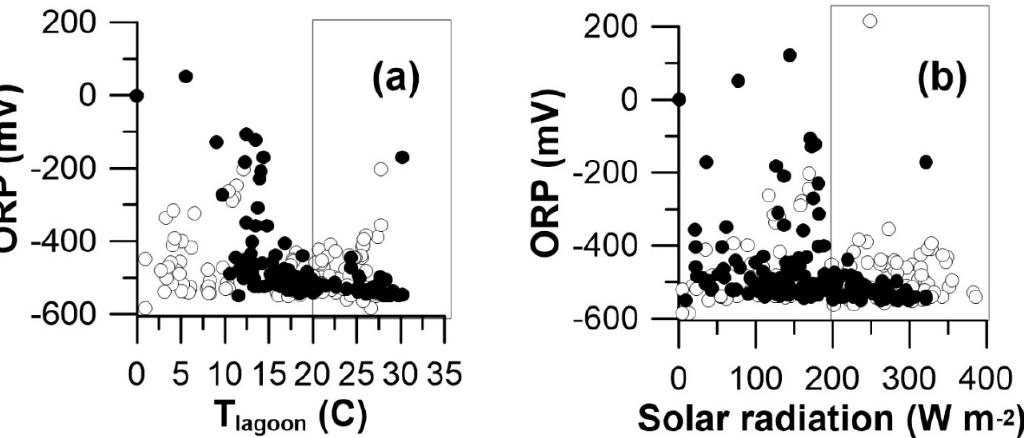
Figure 2. Oxidation-reduction potential: ( a ) The relationship of daily mean lagoon temperature to oxidation-reduction potential in NC (filled circles) and OK (open circles) lagoons; ( b ) The relationship of daily mean solar radiation to oxidation-reduction potential in NC (filled circles) and OK (open circles) lagoons. Conditions conducive to PSB development is indicated by boxed region.